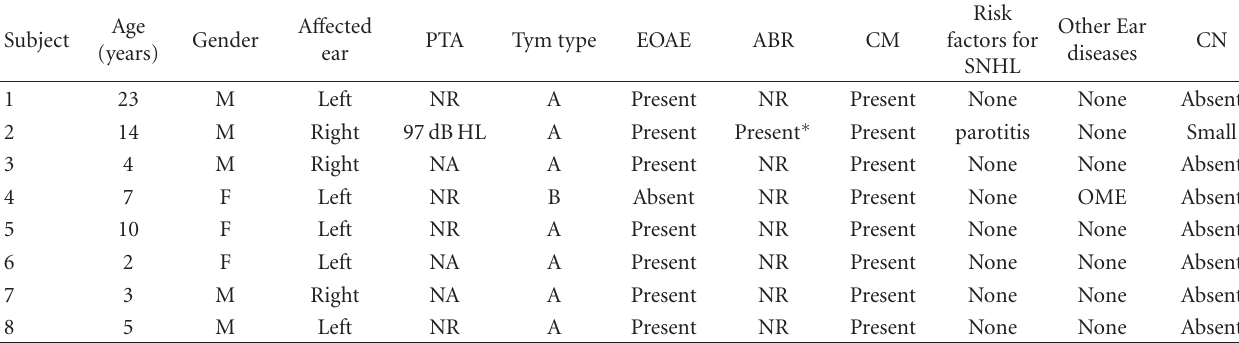
Table 1: Audiological characteristics and radiological findings in patients with